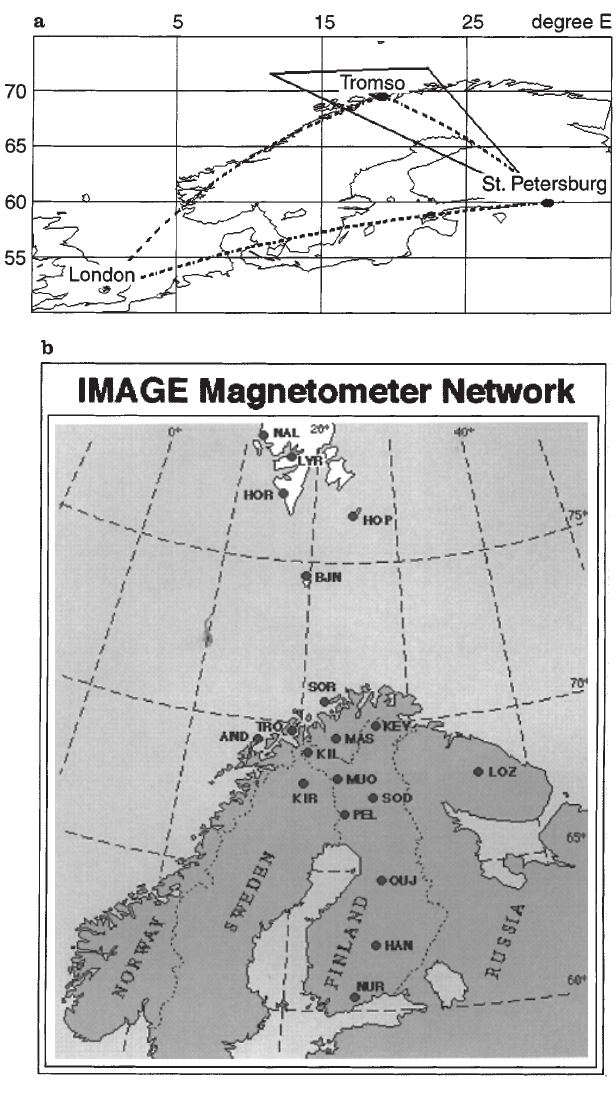
Fig. 1a, b. General view of the experiment geometry: a the radio path where the experimental observations of HF distance diagnostic signals scattered from artificial field-aligned irregularities were made; b locations of the IMAGE magnetometer stations used in this